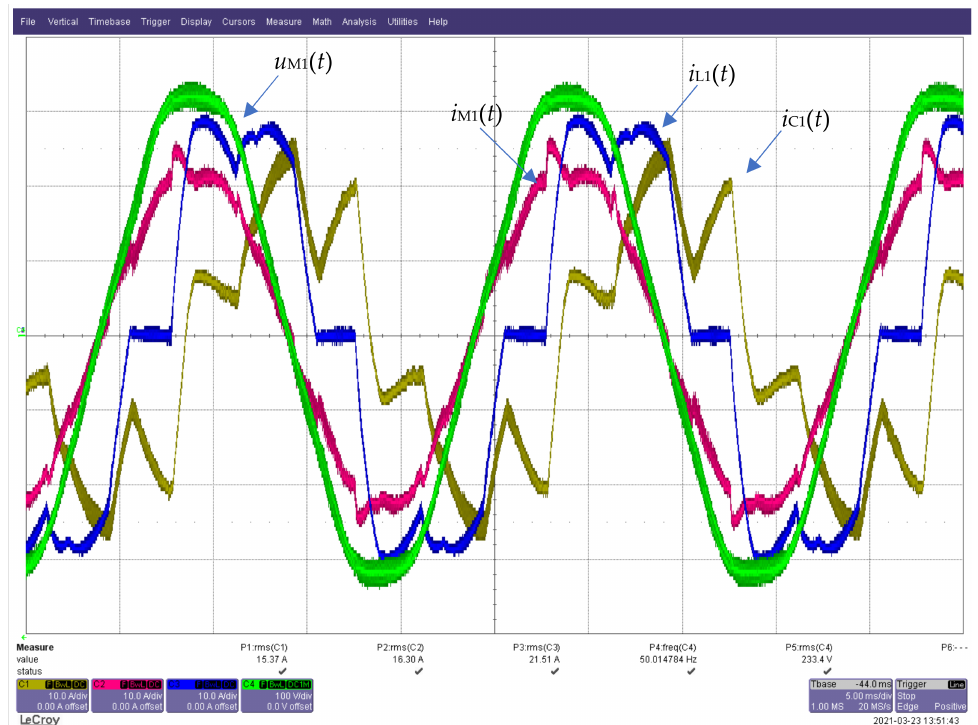
Figure 13. Exemplary experimental waveforms of the APF in steady state: line current i M1 ( t ), compensation current i C1 ( t ), load current i L1 ( t ), and line voltage u M1 ( t